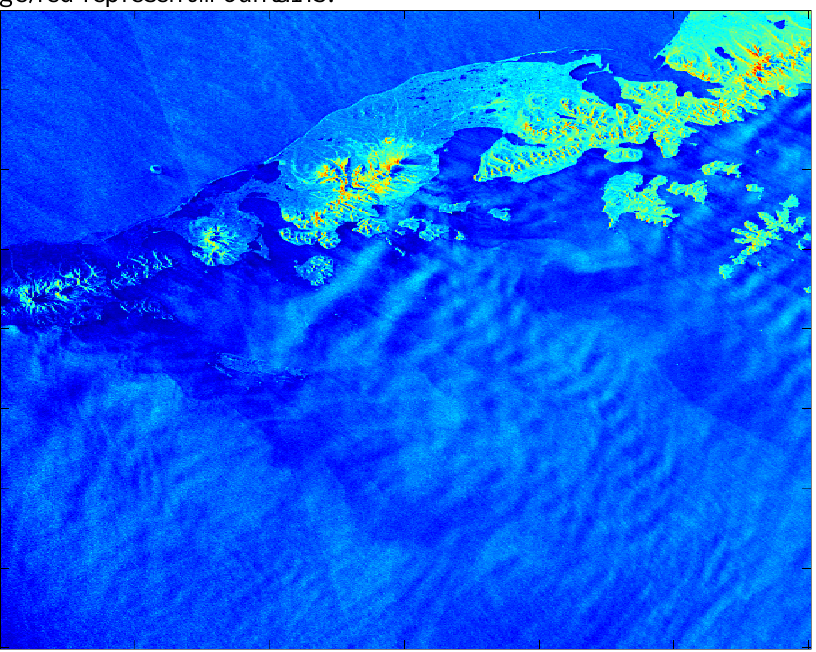
Figure 11. SDWS image for the case study, 0426 UTC on September 1, 2006. Brighter blue represents larger near-surface wind speed. Green represents land and yellow/orange/red represent